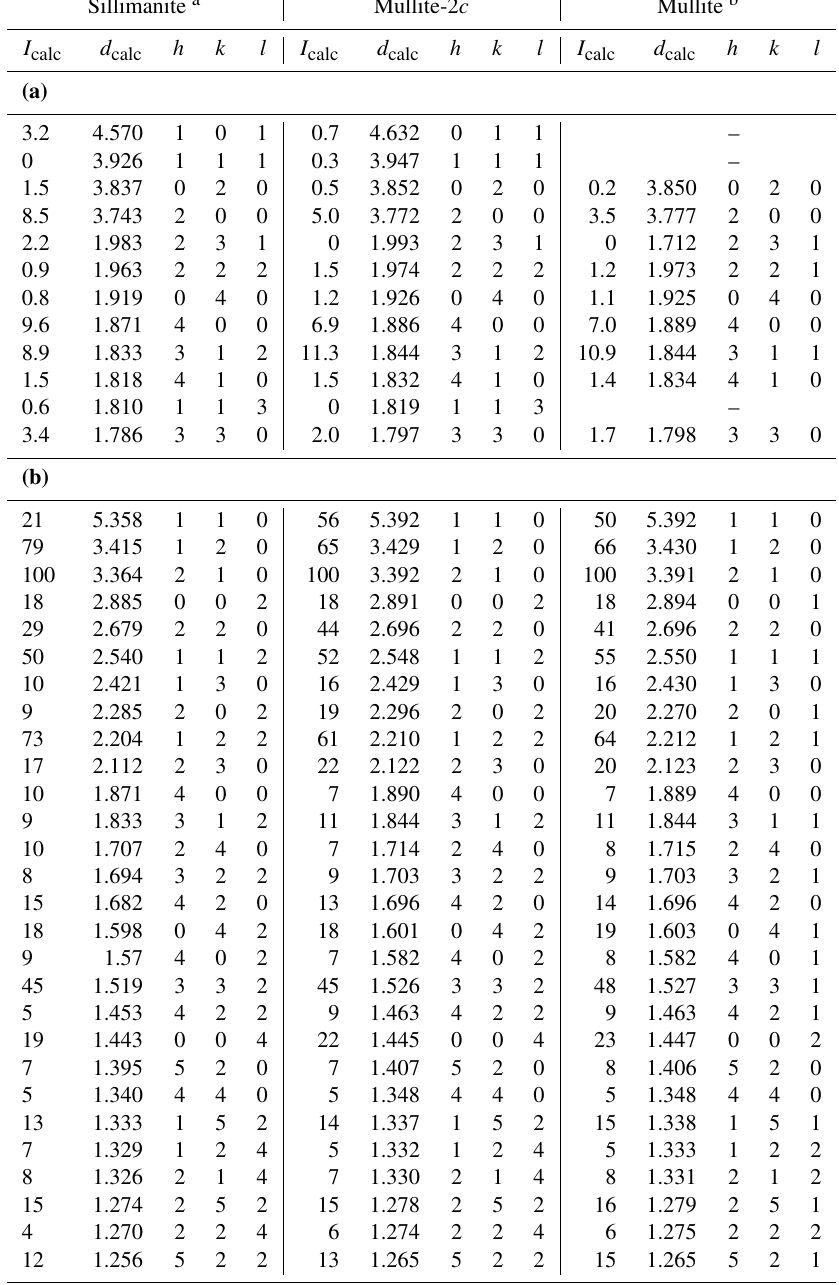
Table 7. (a) Comparison of selected X-ray powder diffraction lines of sillimanite, mullite-2 c and mullite calculated for Cu Kα radiation ( d in Å). (b) Comparison of the strongest calculated X-ray powder diffraction lines of sillimanite, mullite-2 c and mullite for Cu Kα radiation ( d in